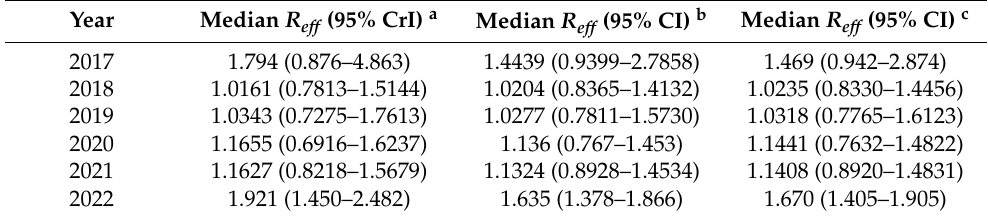
Table 2. Summary results of the median of R eff estimates for MPXV for the data from 1 January 2017 to 27 August